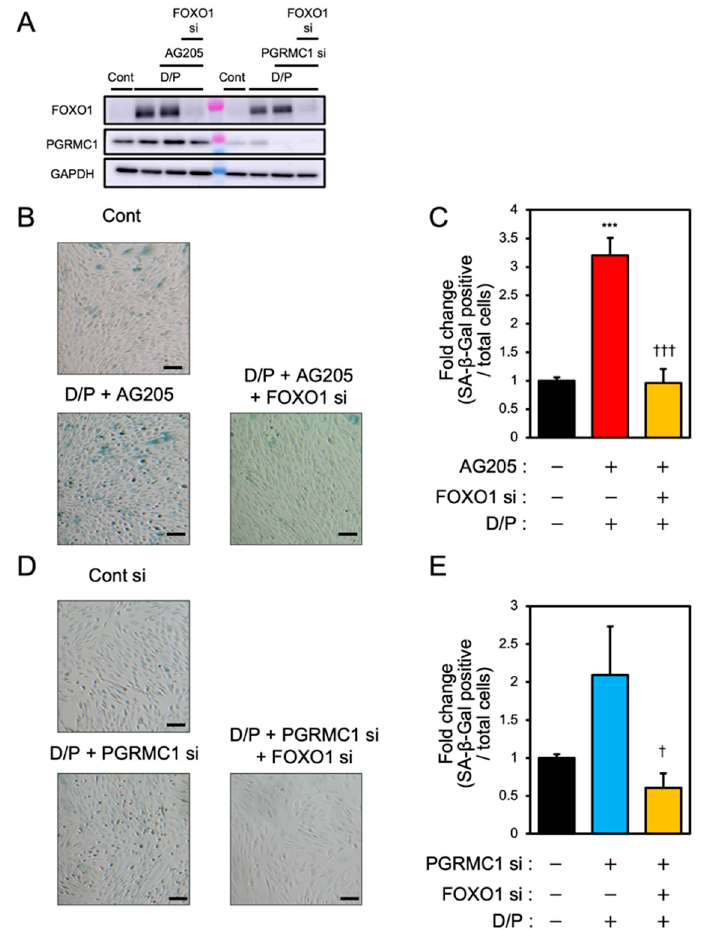
Figure 5. FOXO1 silencing ameliorates PGRMC1 inhibition- and knockdown-induced decidual senescence. ESCs transfected for 1 day with FOXO1 siRNA were treated with D/P in combination with AG-205 or PGRMC1 siRNA for 2 days. ( A ) Knockdown of PGRMC1 and FOXO1 was confirmed by immunoblotting. ( B – D ) Cellular senescence was analyzed by SA- β -Gal staining. ( C , E ) The graph shows the relative ratio of SA- β -Gal-positive cells to total cells. Values represent mean ± SEM from three independent experiments. *** p < 0.001 vs. control. † p < 0.05 vs. D/P + PGRMC1 siRNA. ††† p < 0.001 vs. D/P + AG-205. Scale bars = 100 μ m. Red bar: AG205-treated group. Blue bar: the PGRMC1 siRNA-transfected group. Yellow bars: the PGRMC1/FOXO1 siRNA-transfected group.